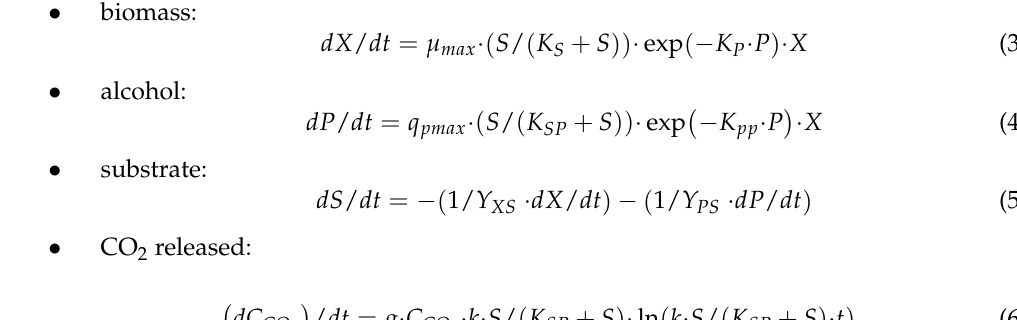
Figure 9. Generated results by the NN vs. experimental values using the first and second variants input-output configurations of NN.